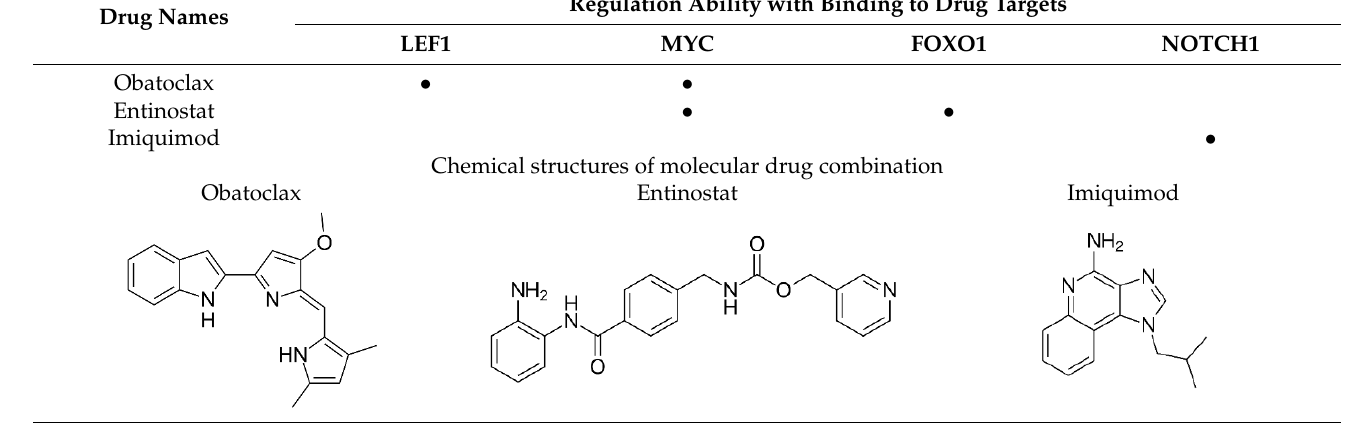
Table 3. The selected molecular drugs and their corresponding drug targets for the drug combination as the multiple-molecule drug for the treatment of ABC.